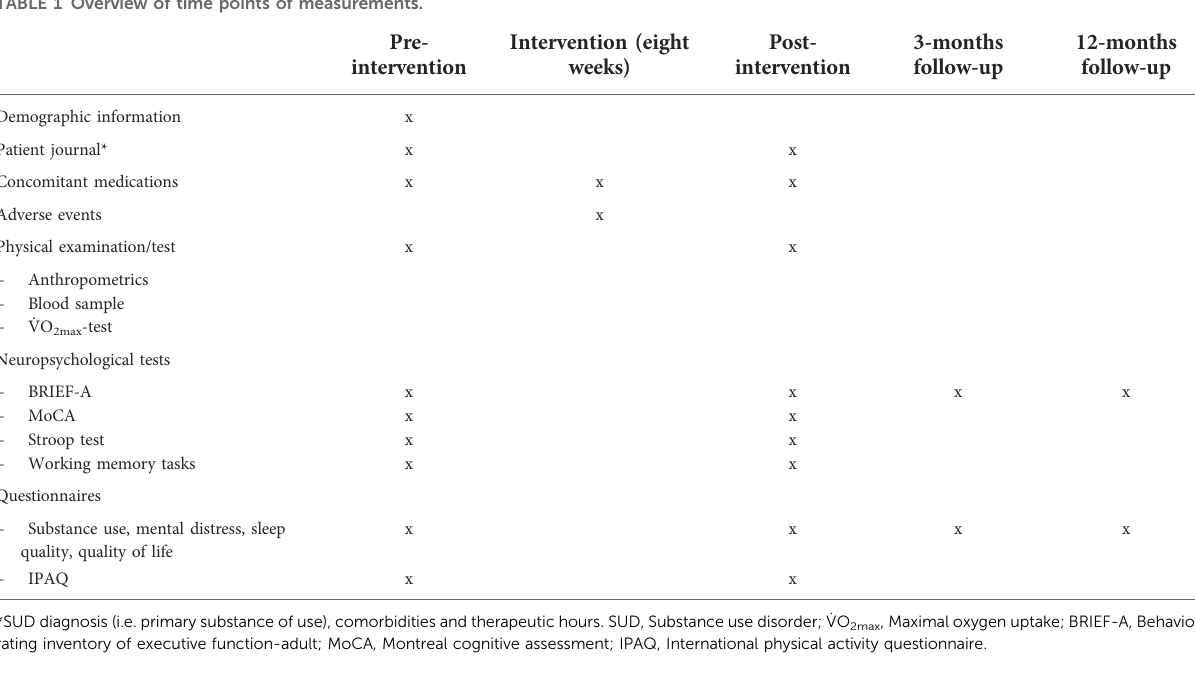
TABLE 1 Overview of time points of measurements.